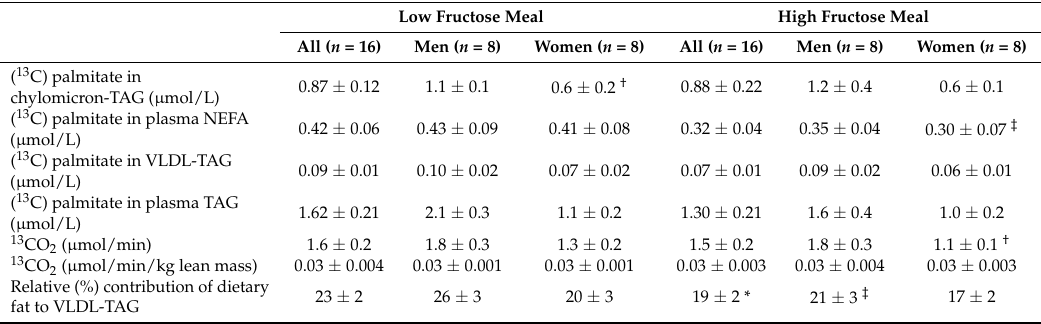
Table 3. The time-averaged postprandial incorporation of 13 C (from dietary fat) into plasma and breath and the contribution of dietary fat to VLDL-TAG after consumption of a low- and high-fructose meal. Low Fructose Meal High Fructose Meal All ( n = 16) Men ( n = 8) Women ( n = 8) All ( n = 16) Men ( n = 8) Women ( n = 8) ( 13 C) palmitate in